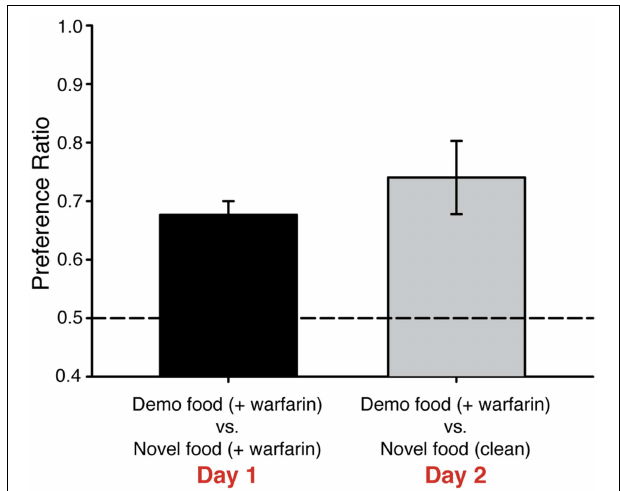
FIGURE 3 | Mice prefer demonstrated food containing warfarin to novel food without the rodenticide. C57BL/6J mice ( n = 10 ) were demonstrated a food odor paired with 50nM UG. On Day 1, mice preferred food containing the demonstrated over food with a novel odor, although both foods contained warfarin (0.025%). On Day 2, these mice continued to prefer food containing both the demonstrated odor and warfarin even though the other food choice contained a novel odor but no warfarin. One-Way ANOVA [ F (1 , 19) = 10 . 1 , P < 0 . 005 ], followed by Tukeys post-hoc test ( * P < 0 . 01 ). Dashed lines, no preference. Error bars, standard error of the